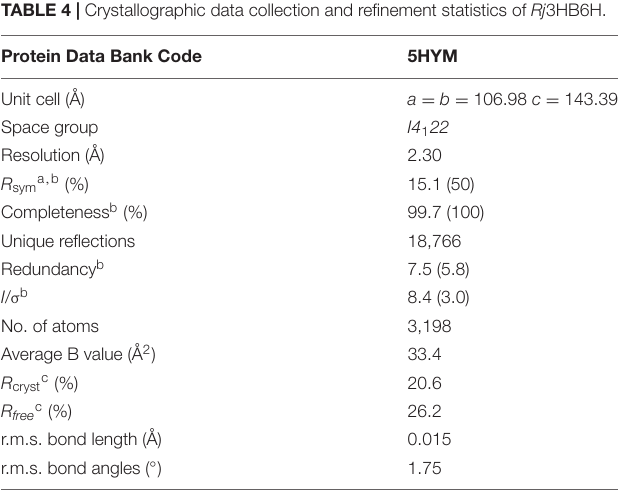
TABLE 4 | Crystallographic data collection and refinement statistics of Rj